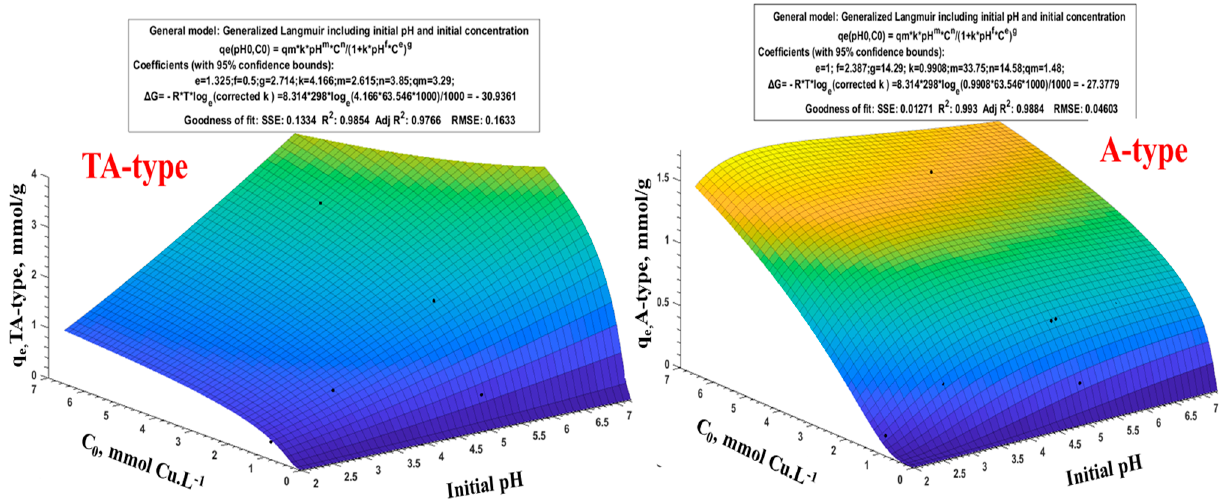
Figure 9. Generalized Langmuir model, including Cu(II) adsorption (q e ) vs. initial pH and C 0 .